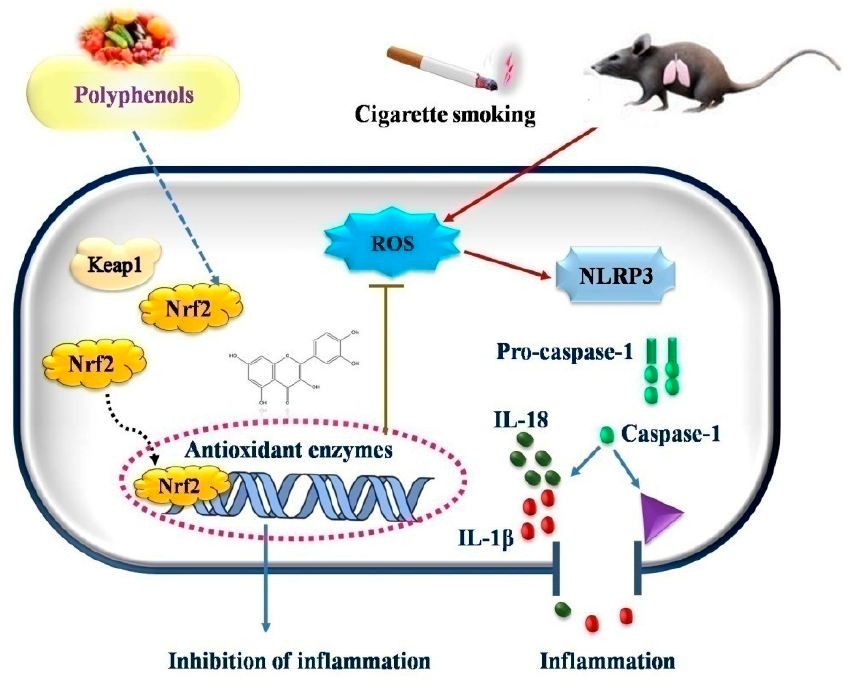
Figure 3. Possible mechanism of action of polyphenols in oxidative stress induced diseases.